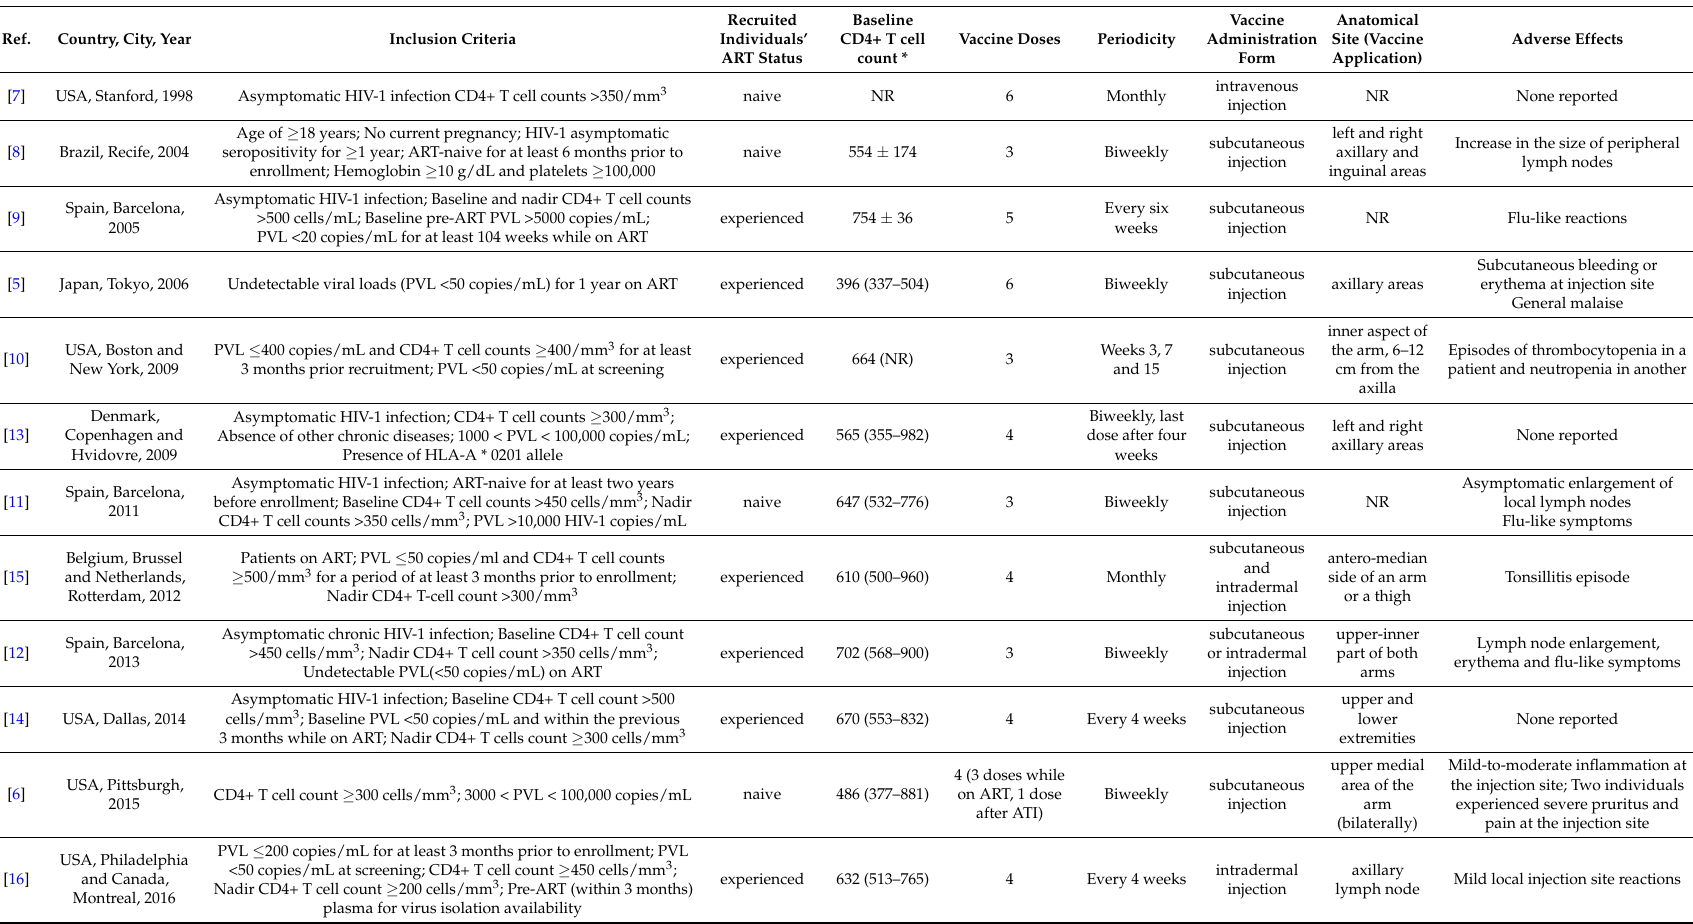
Table 1. Summary of the 12 studies characteristics that were included in the meta-analysis.